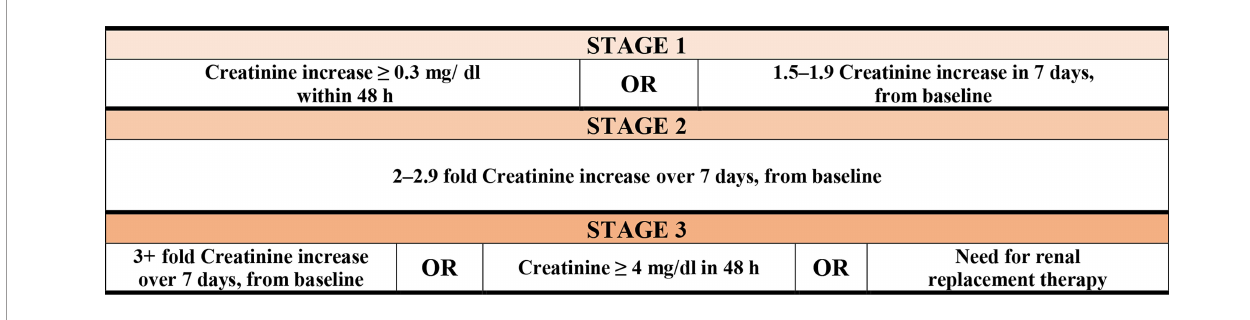
FIGURE 3 | Stages of renal failure by kidney disease according to Improving Global Outcomes